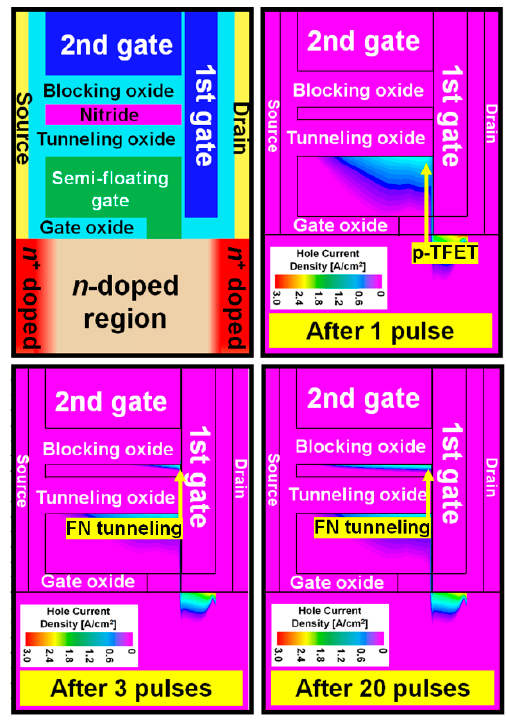
Figure 5. Hole current density after successive potentiation pulses, V GS1 = V GS2 = − 1.5 V. As the number of pulses increases, the holes at the Fermi distribution tail accumulated in the SFG region see the triangular energy barrier and become more probable for injection into the nitride by FN tunneling.